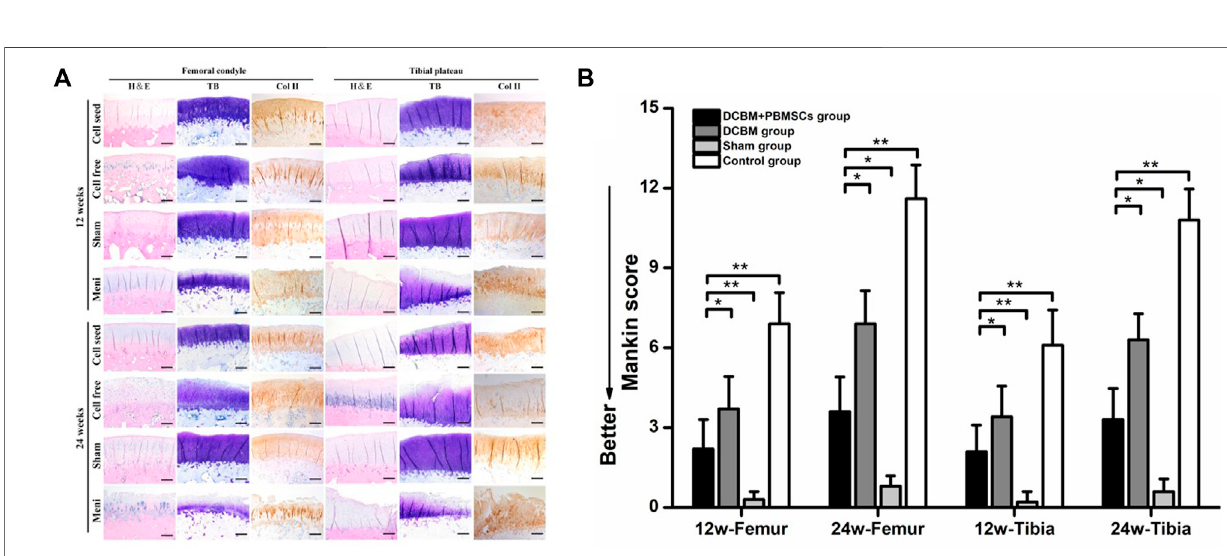
Frontiers in Bioengineering and Biotechnology |